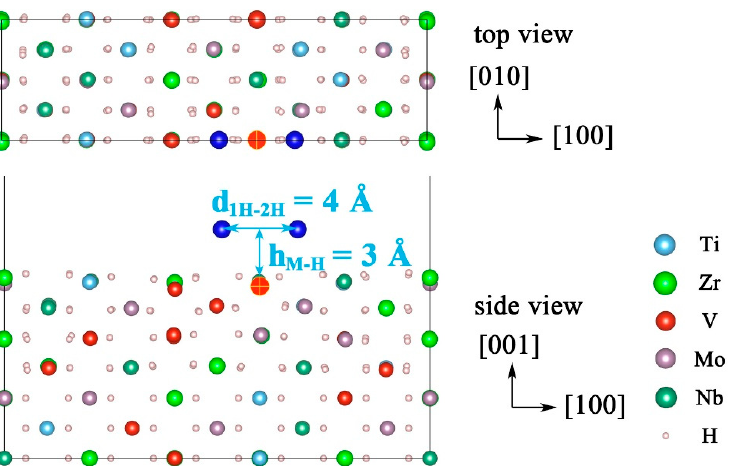
Figure 6. Schematic view of the considered configuration for the parallel atomic hydrogen desorption on the HEA TiZrVMoNb hydride (110) surface with an initial height (h M-H ) of 3.0 Å. The desorbed H atoms are represented by dark blue spheres. Here, d 1H-2H is the distance between the two desorbed hydrogen atoms before structural optimization. Here, h M-H is the vertical distance between the desorbed hydrogen atoms and the nearest-neighboring metal atom on surface before structural optimization. Table 2. Structural parameters and energy difference (∆𝐸 = 𝐸 (cid:2887)(cid:2925)(cid:2924)(cid:2916).(cid:2924) − 𝐸 (cid:2887)(cid:2925)(cid:2924)(cid:2916).(cid:2869) ,𝑛 = 1,2,…,6) see Table 1. and other config- urations for atomic hydrogen desorption with an initial height of 3.0 Å. See Table 1 for a description of h’ M-1H , h’ M-2H , d’ 3H- 1H and d’ 3H-2H . The geometrical structures for the considered six configurations are shown in Figure 2. Configuration